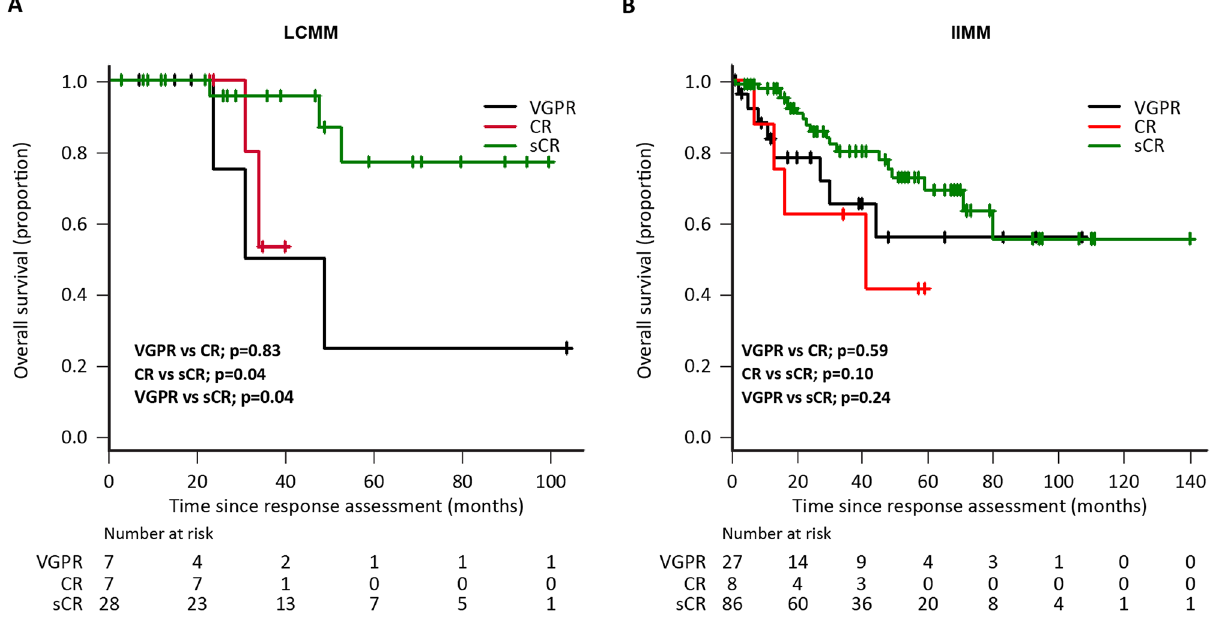
Figure 1. Overall survival according to best response, as defined by IMWG. ( A ) LCMM, ( B ) IIMM. IIMM, intact immunoglobulin multiple myeloma; IMWG, International Myeloma Working Group; LCMM, light chain multiple